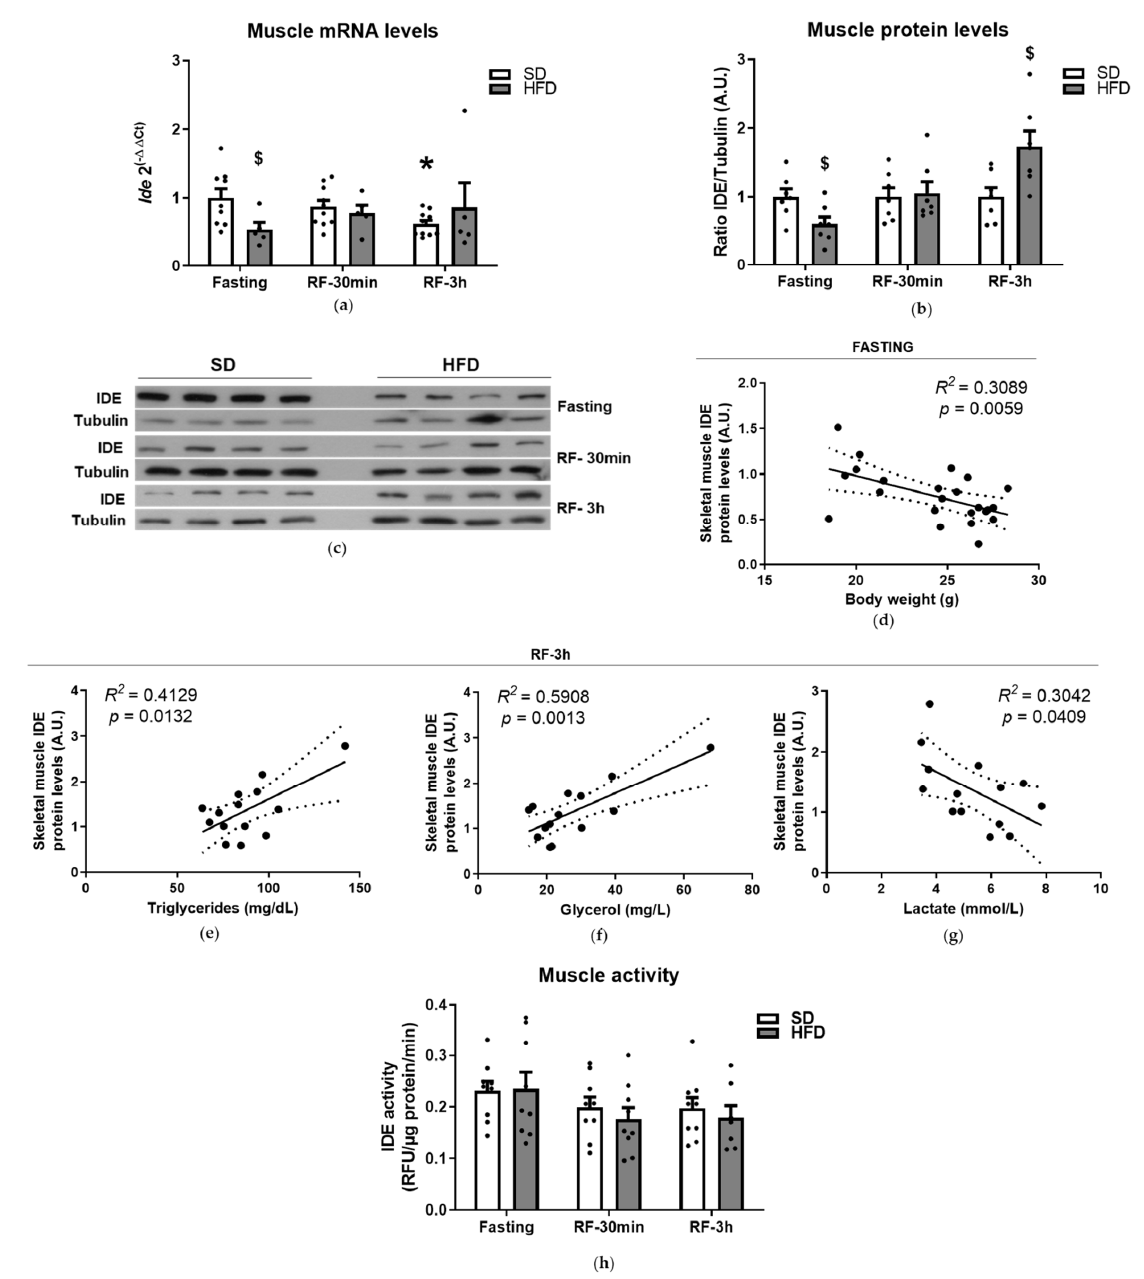
Figure 4. Regulation of IDE mRNA and protein in muscle. ( a ) Regulation of Ide gene expression. Total mRNA was isolated and quantified from muscle tissues of mice fed an SD or HFD during fasting or refeeding conditions. Data are the means ± SEM. N = 5–9 mice per condition. * p < 0.05 vs. fasting by ANOVA. $ p < 0.05 vs. SD by ANOVA. ( b ) Regulation of IDE protein levels. Lysates from muscles of mice fed an SD or HFD, during fasting or refeeding conditions, were resolved by Western blots and IDE was quantified by densitometric analyses using full blots (Appendix A, Figure A2c). Then, data were plotted for each nutritional status and diet. Data are the means ± SEM. N = 10–11 mice per condition. $ p < 0.05 vs. SD by ANOVA. ( c ) Representative image illustrating IDE protein levels in muscle showed in “panel b”. Regression analyses. Bivariate analyses were performed using data from mice fed an SD and HFD, during fasting or refeeding conditions. Correlations between IDE protein levels in muscle and body weight ( d ), plasma triglycerides ( e ), plasma glycerol ( f ), and plasma lactate ( g ). The R 2 and statistical significances ( p ) values are indicated in the figure. ( h ) Regulation of IDE activity levels. Effects of the nutritional status on hepatic IDE activity. Lysates from muscles of mice fed an SD or HFD, during fasting or refeeding conditions, were assessed for its activity as described in Section 2. Data are the means ± SEM. N = 9 mice per